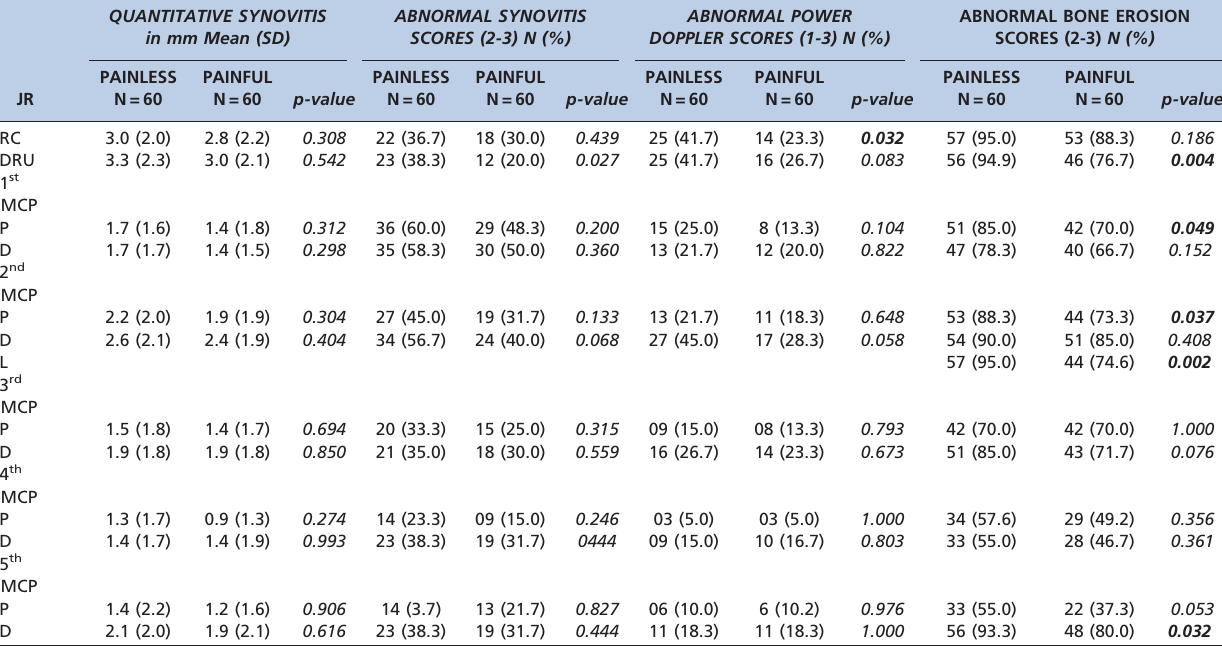
Table 5 - Ultrasound findings for each joint. QUANTITATIVE SYNOVITIS in mm Mean